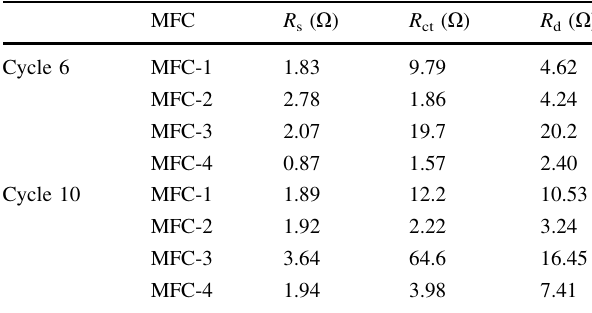
Fig. 7 Electrochemical impedance spectroscopy analysis of the cathodes a after six cycles, b after ten cycles, respectively Table 3 Nyquist plot data for the MFCs